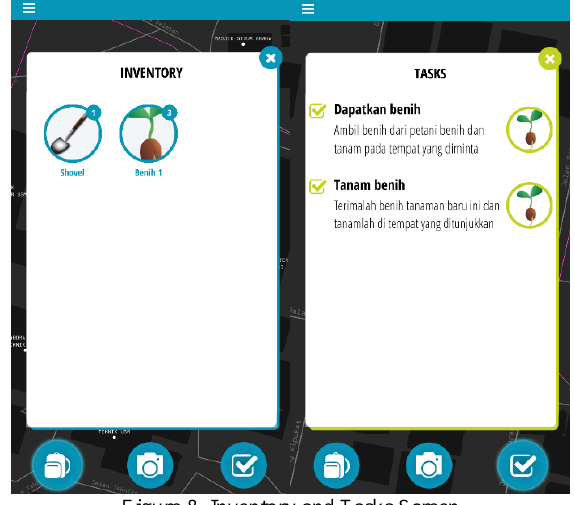
Figure 8. Inventory and Tasks Screen